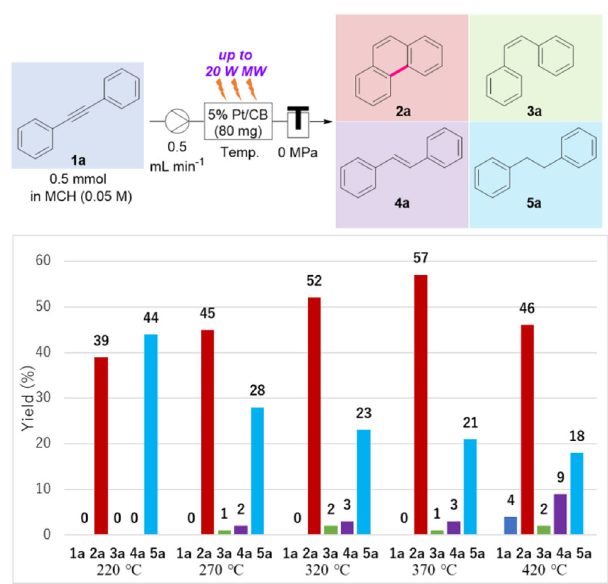
Fig. 3 Effect of temperatures in the catalyst cartridge. Composition of the substrate ( 1a ) and products ( 2a – 5a ) under MW-assisted fl ow, isothermal conditions. Yields were determined by 1 H NMR using 1,1,2,2- tetrachloroethane (0.5 mmol) as an internal